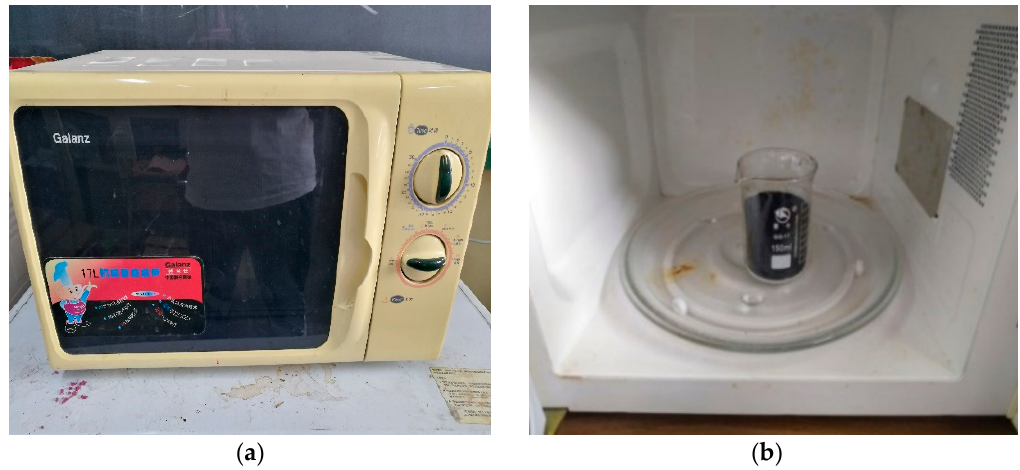
Figure 1. Rubber powder activation equipment: ( a ) microwave oven and ( b ) microwave-activated crumb rubber.